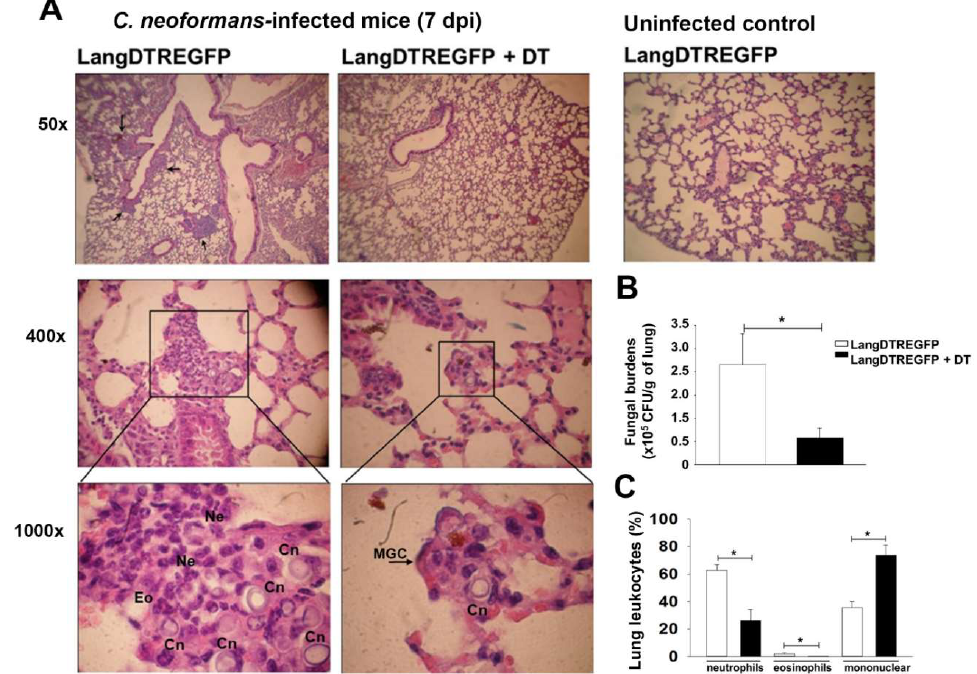
Figure 2. LangDC1-depleted mice better control pulmonary C. neoformans infection. ( A ) Histopathol- ogy (H&E) of lung sections from untreated or DT-treated LangDTREGFP mice, intratracheally infected with C. neoformans or uninfected (controls). Arrows (upper panels) and squares (middle and bottom panels) show inflammatory infiltrates and C. neoformans yeasts (Cn). Ne: neutrophils; Eo: eosinophils; MGC: multinucleated giant cells. ( B ) Fungal burden in lung homogenates (CFU/g) from DT-treated (black bars) or untreated (white bars) 7-day-infected LangDTREGFP mice. Data are mean ± SEM ( n = 6 animals per group) of two independent experiments. * p < 0.037. ( C ) Percentages of neu- trophils, eosinophils and mononuclear cells present in inflammatory infiltrates were counted per high-powered field within lung sections from DT-treated (black bars) or untreated (white bars) 7-day- infected LangDTREGFP mice. Data are mean ± SEM ( n = 3 mice per group); two tissue samples from each animal were analyzed at a magnification of 1000X. * p < 0.005. All data were analyzed with Student’s t -test or ANOVA. DT: diphtheria toxin; dpi: days post infection; CFU: colony-forming